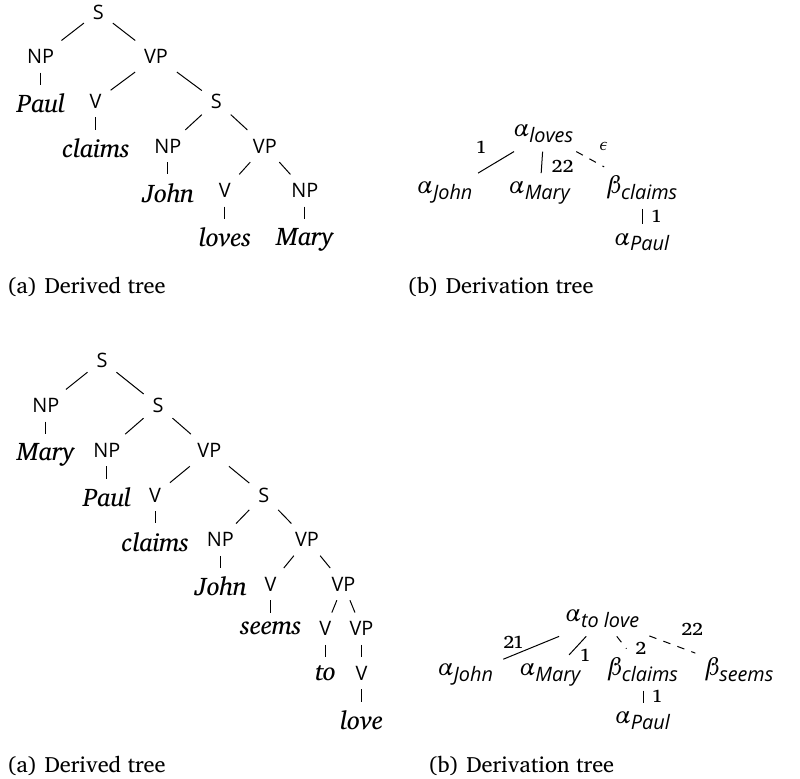
Mary, Paul claims John seems to